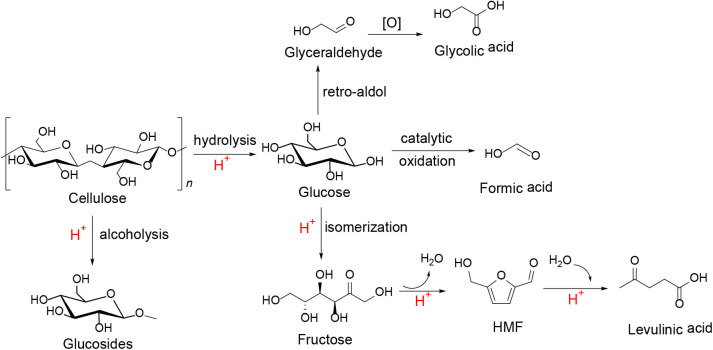
Conversion of cellulose to other substance with an HPA catalyst (H+, HPA catalyst).